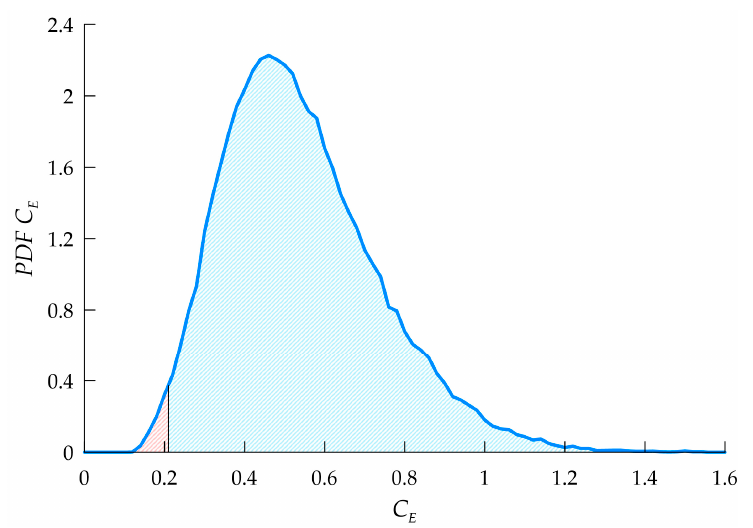
Figure 3. 𝐶 (cid:3006) probability density function for Δ = 256 ℎ . The region on the left corresponding to 1% Figure 3. C E probability density function for ∆ = 256 h The region on the left corresponding to 1% of of total probability is shown in red. total probability is shown in red.